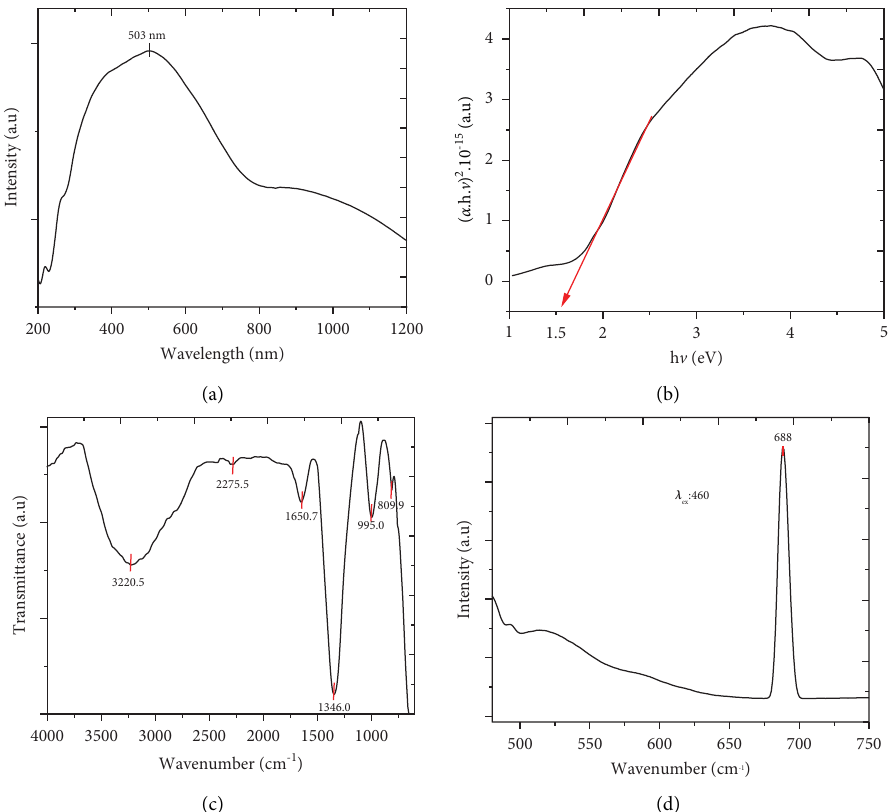
Figure 2: (a) UV-Vis difuse refectance spectra, (b) direct bandgap, (c) Fourier transform infrared analysis (FT-IR), and (d) photo- luminescence spectra of Fe 2 O 3